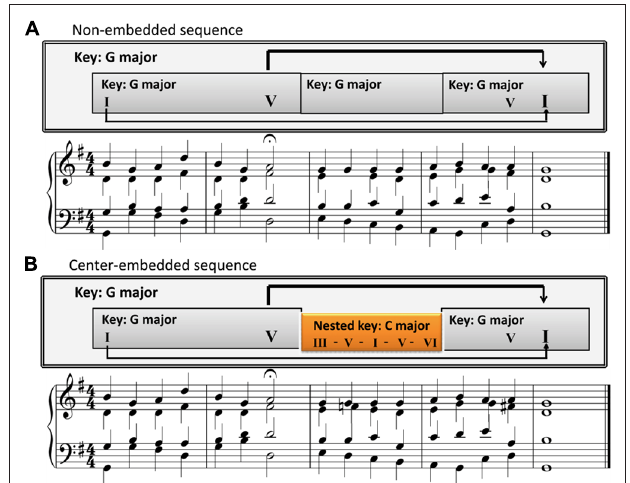
FIGURE 1 | A sample excerpt illustrating the two sequences with different structures. (A) The non-embedded sequences. Chord sequences without transition or modulation segments. All parts are in G major. (B) The center- embedded sequences. Chord sequences with transition or modulation segments. The C major segment is nested into an overarching key of G